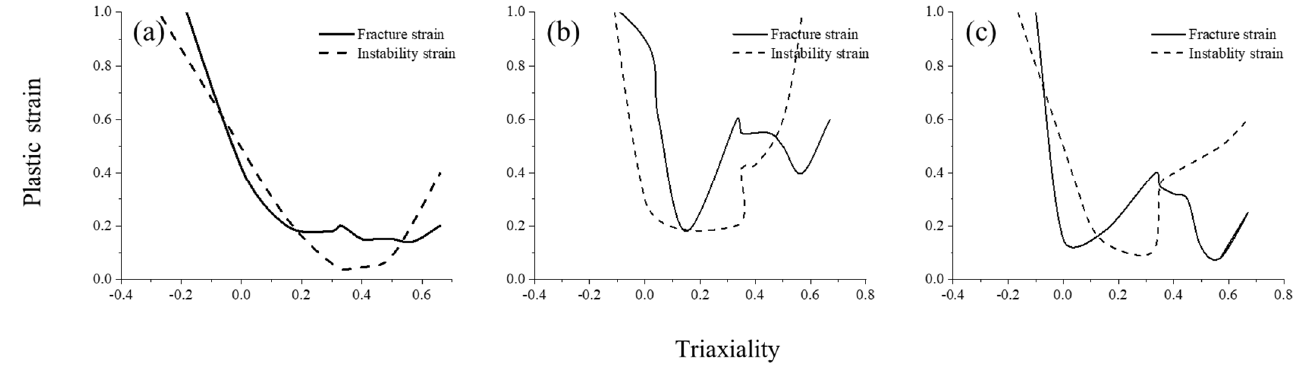
Figure 8. Optimized failure and instability loci using GISSMO for shell-based models: ( a ) MAT 1, ( b ) MAT 2, and ( c ) MAT 3.